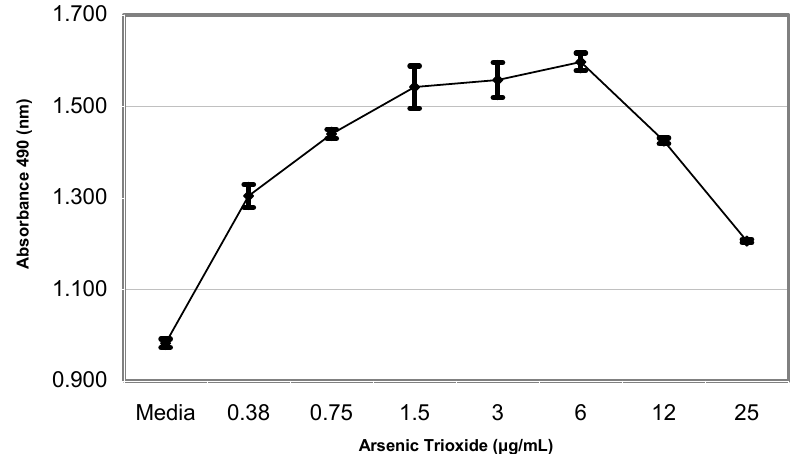
Figure 2. Proliferation of HaCaT cells exposed to arsenic trioxide. Cells were seeded in 96 well plates (2,500 cells / well). Arsenic-treated and control cells were rendered quiescent and stimulated with different doses of arsenic trioxide in triplicates. Each point represents the mean of three